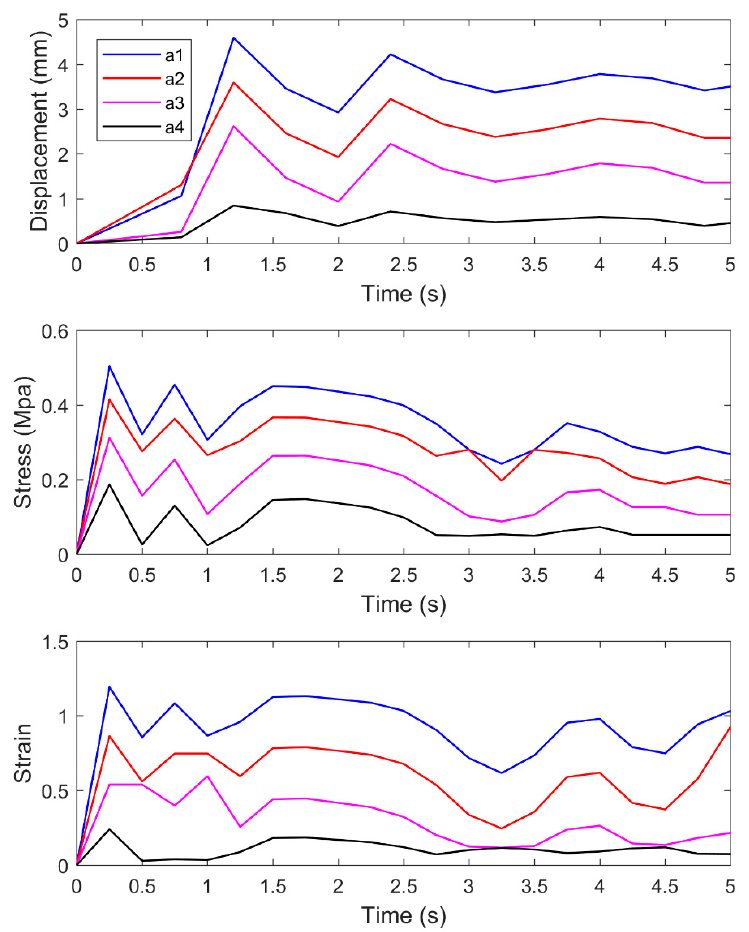
Figure 11. Curves of displacement, stress, and strain of vertical monitoring points with time.